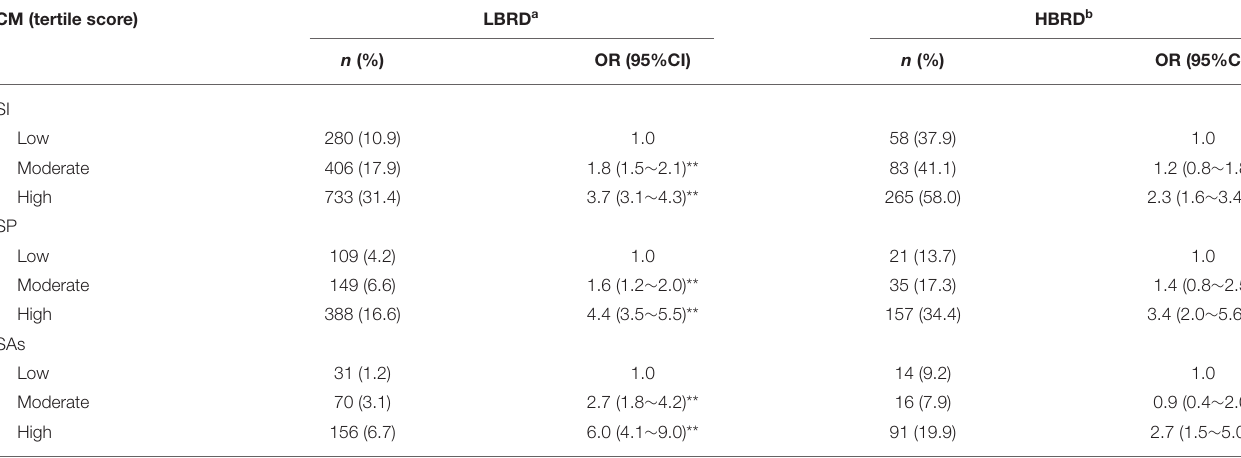
TABLE 3 | Number, % and adjusted OR of suicidal behaviors by level of CM and BR. CM (tertile